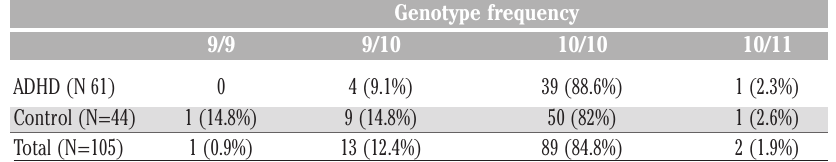
Table 1. Distribution of the DAT1 genotypes.